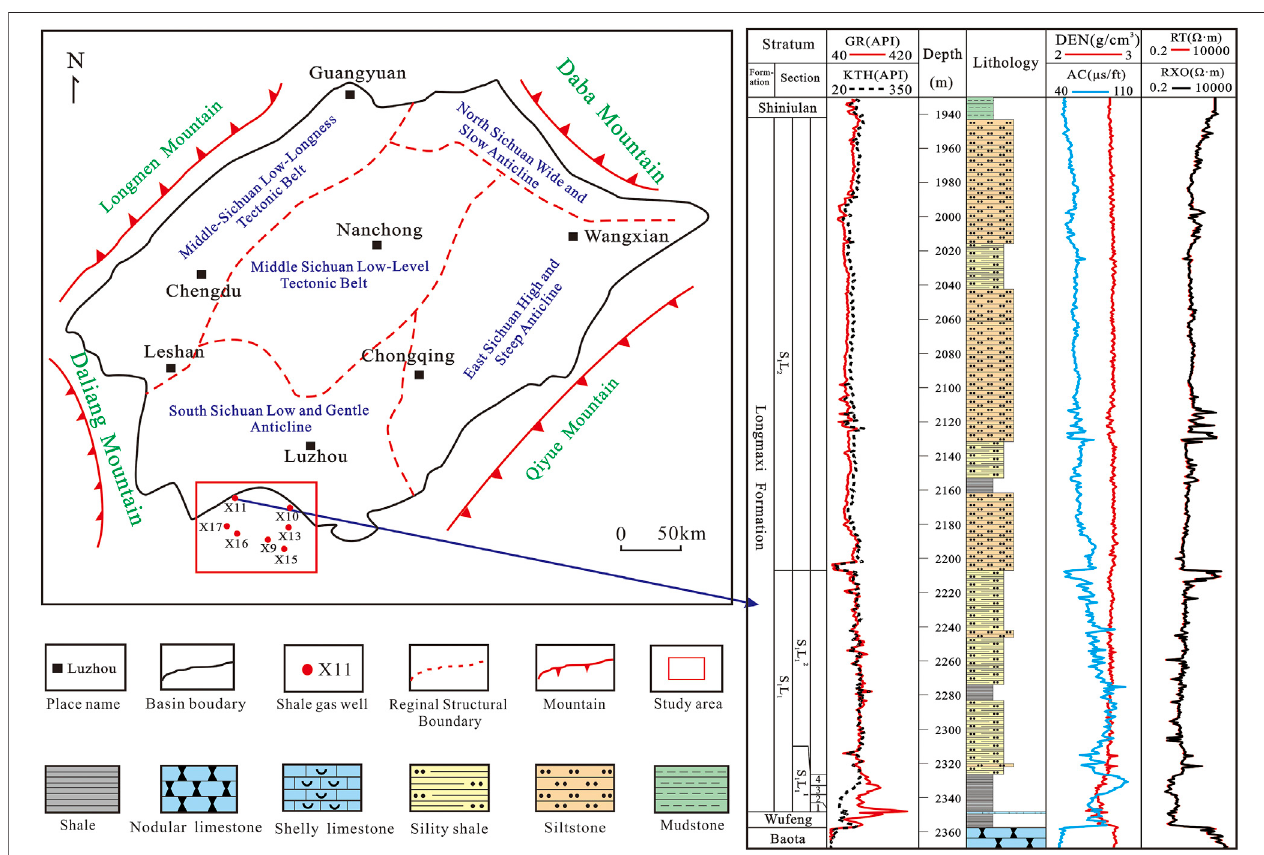
FIGURE 1 | The location of the study area and stratigraphic column of the Longmaxi Formation of the X11 Well (Chen et al., 2019).